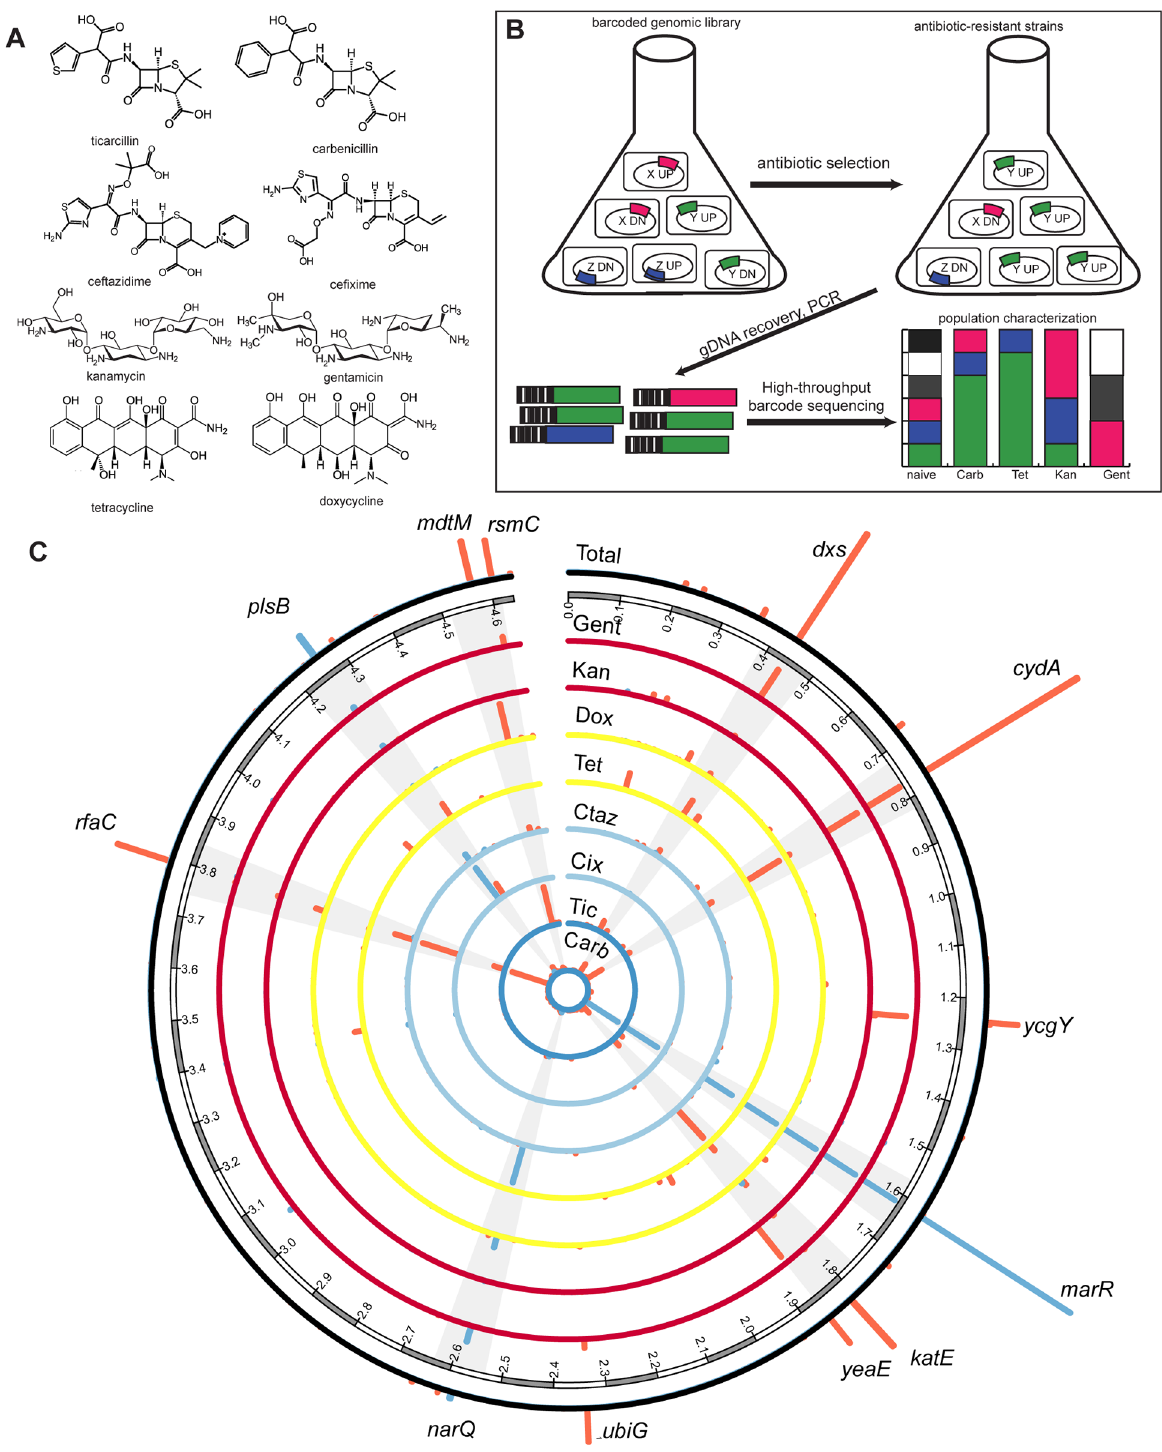
Fig 1. Selection of a genome-scale library on several antibiotics yields multi-drug resistant genes. (a) Chemical structures of the eight antibiotics used in this study. (b) The TRMR library containing strains simulating “ up ” or “ down ” expression phenotypes in E . coli is grown in selective conditions. The genomic DNA of the survivors is harvested and amplified by PCR and the amplicon is sent to high-throughput sequencing, after which it is analyzed. (c) Enrichment scores for TRMR “ up ” (blue) or “ down ” (red) alleles for particular antibiotics are plotted relative to their location in the E . coli genome (in Mb). Alleles enriched in many or all selections are highlighted. The outside ring represents a linear combination of all eight antibiotic